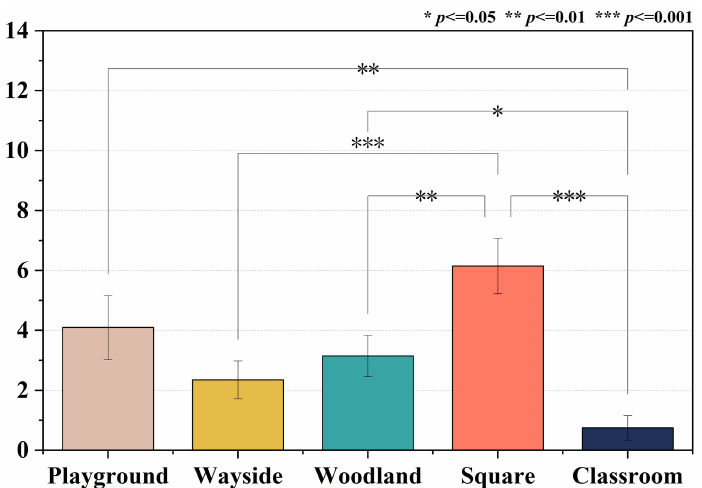
Figure 4. Comparison of the recovery degree from eye strain in different